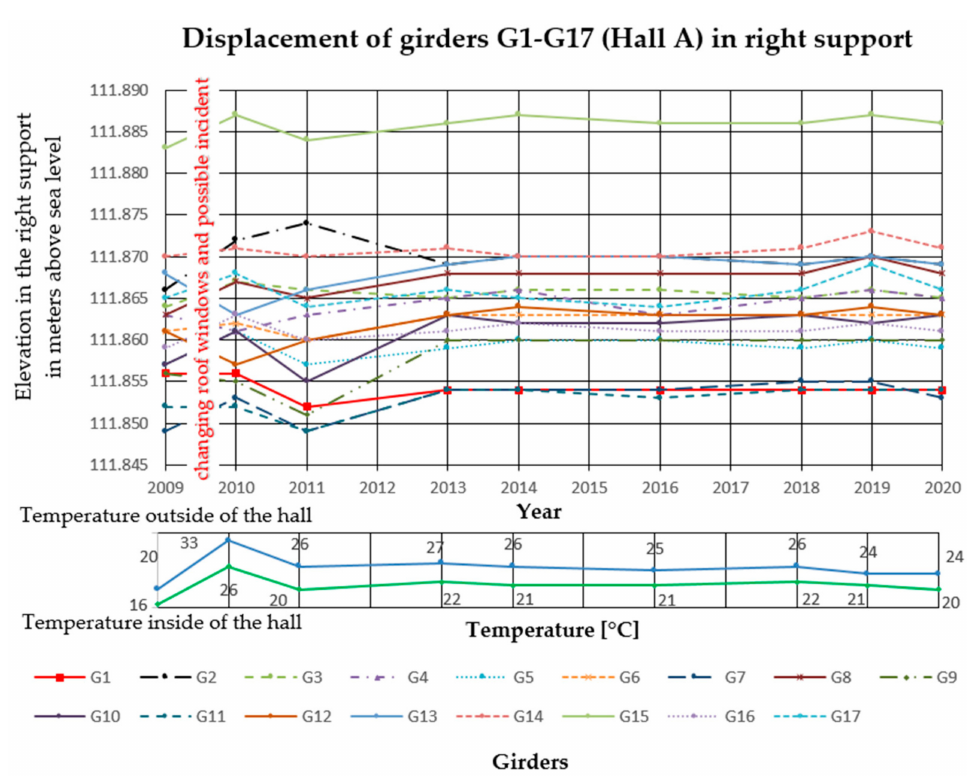
Figure 7. Displacement of the right side of the girders in Hall A.